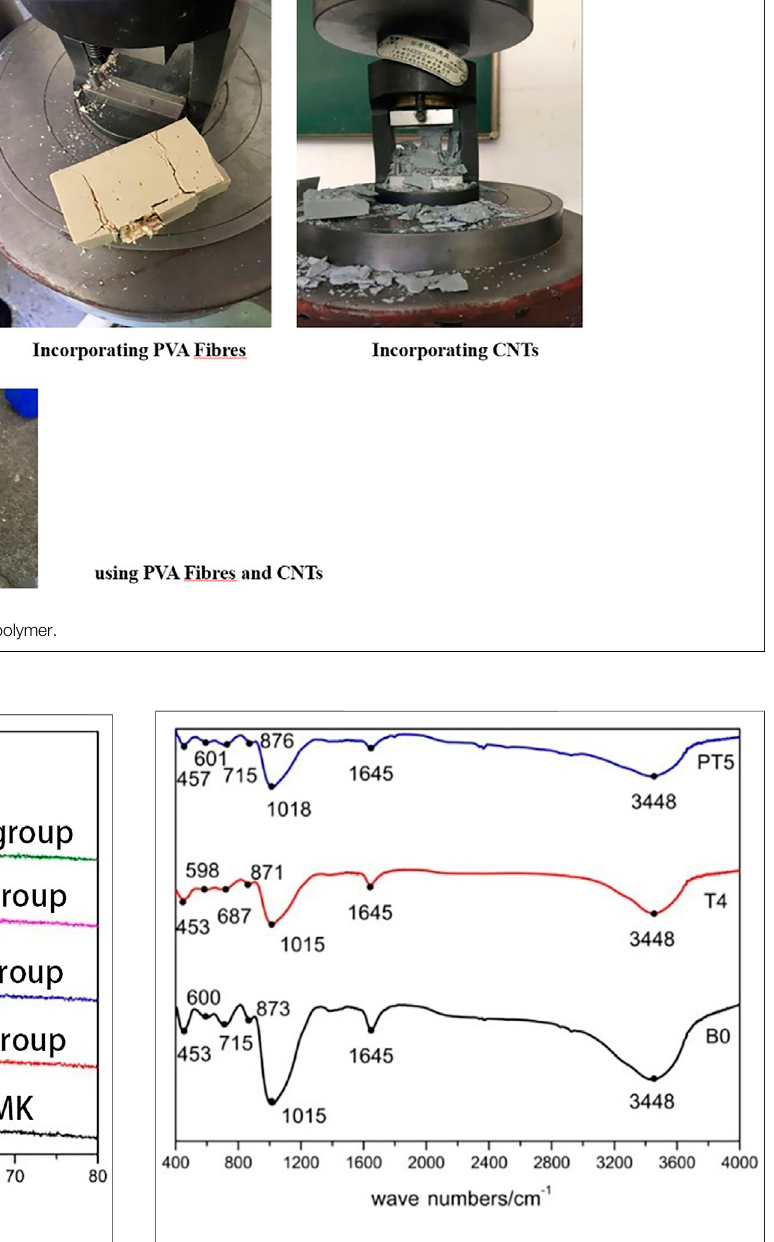
FIGURE 6 | 28-day XRD pattern of PVA fi bre and CNT-strengthened geopolymer and metakaolin (MK).